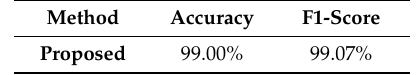
Table 1. Benchmarks comparison for the proposed pipeline.